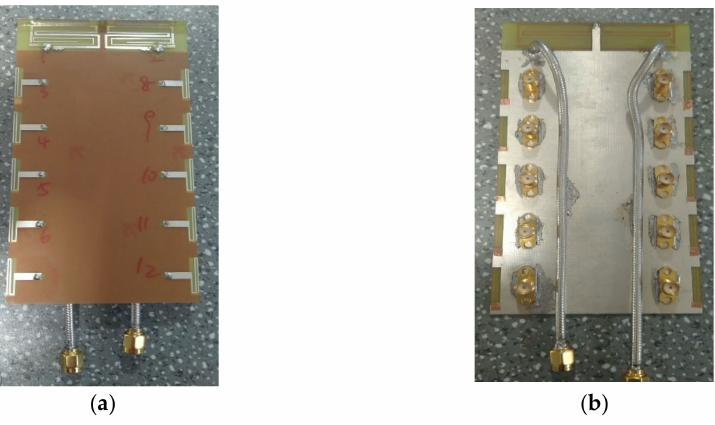
Figure 7. MIMO system based on CMA: ( a ) top view; and ( b ) back view (Results from